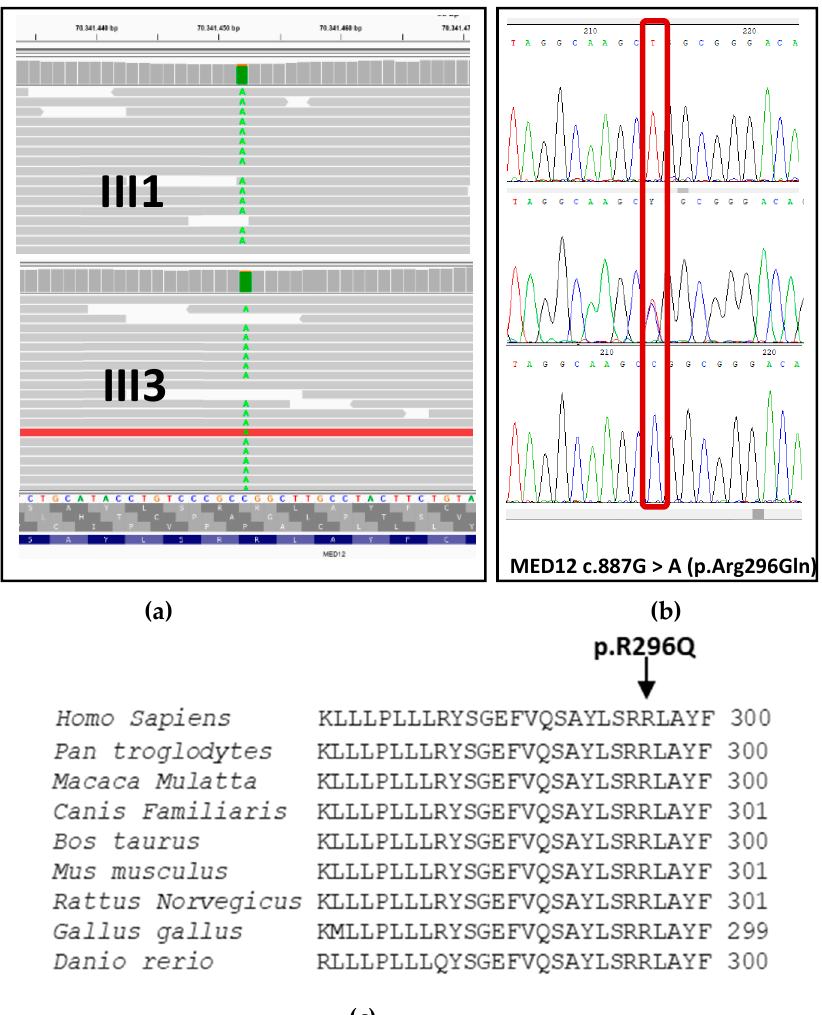
Figure 2. NGS data analyzed with IGV software and Sanger sequencing data analyzed with Chromas. ( a ) Photographs of IGV analysis reporting the c.887G > A, p.(R296Q) variant. Green line represents the variable base in IGV visualization ( b ) Sanger sequencing results of MED12 gene variant c.887G > A, p.(R296Q) in two affected individuals III-1, III-3 (hemizygous) and the unaffected mother II-3, II-4 (heterozygous). The site of the pathogenic variant is marked by a red line. ( c ) Alignment analysis of the amino acid sequences of MED12 from different species, showing complete conservation of the identified mutated residue (arrow).